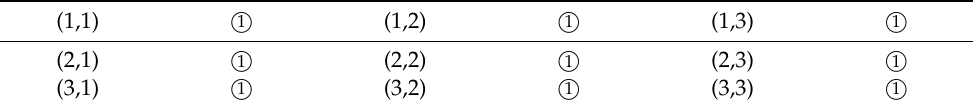
Table 4. Vertical entry detection